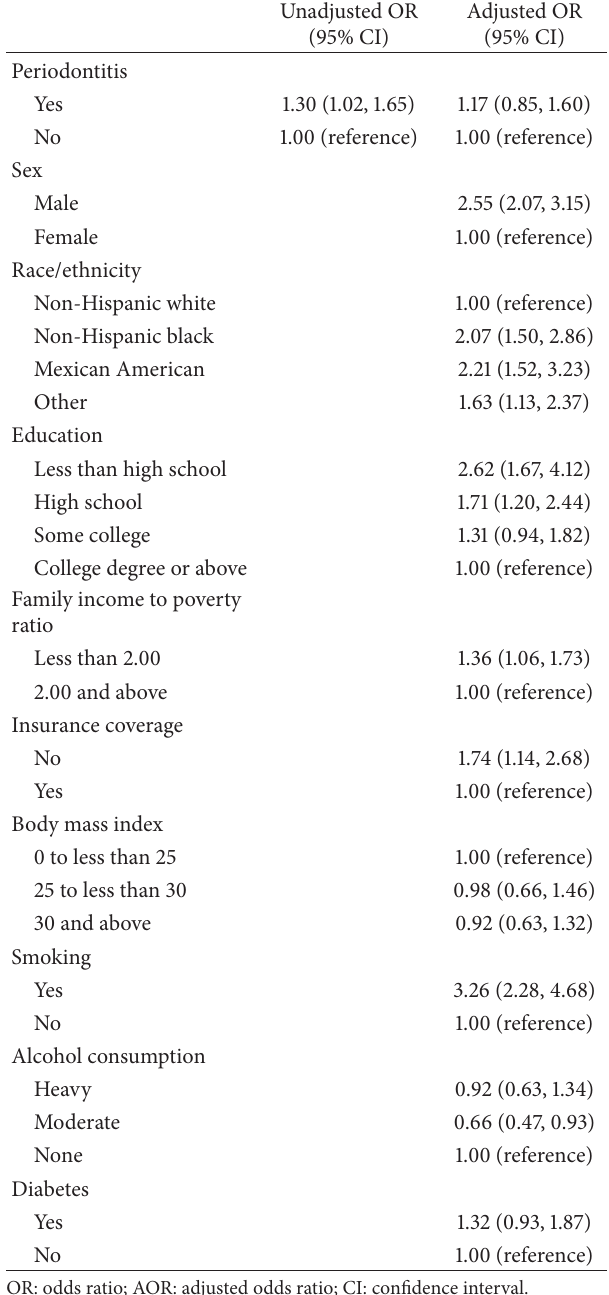
Table 3: Logistic regression of serum Alanine Aminotransferase on periodontal status: NHANES,